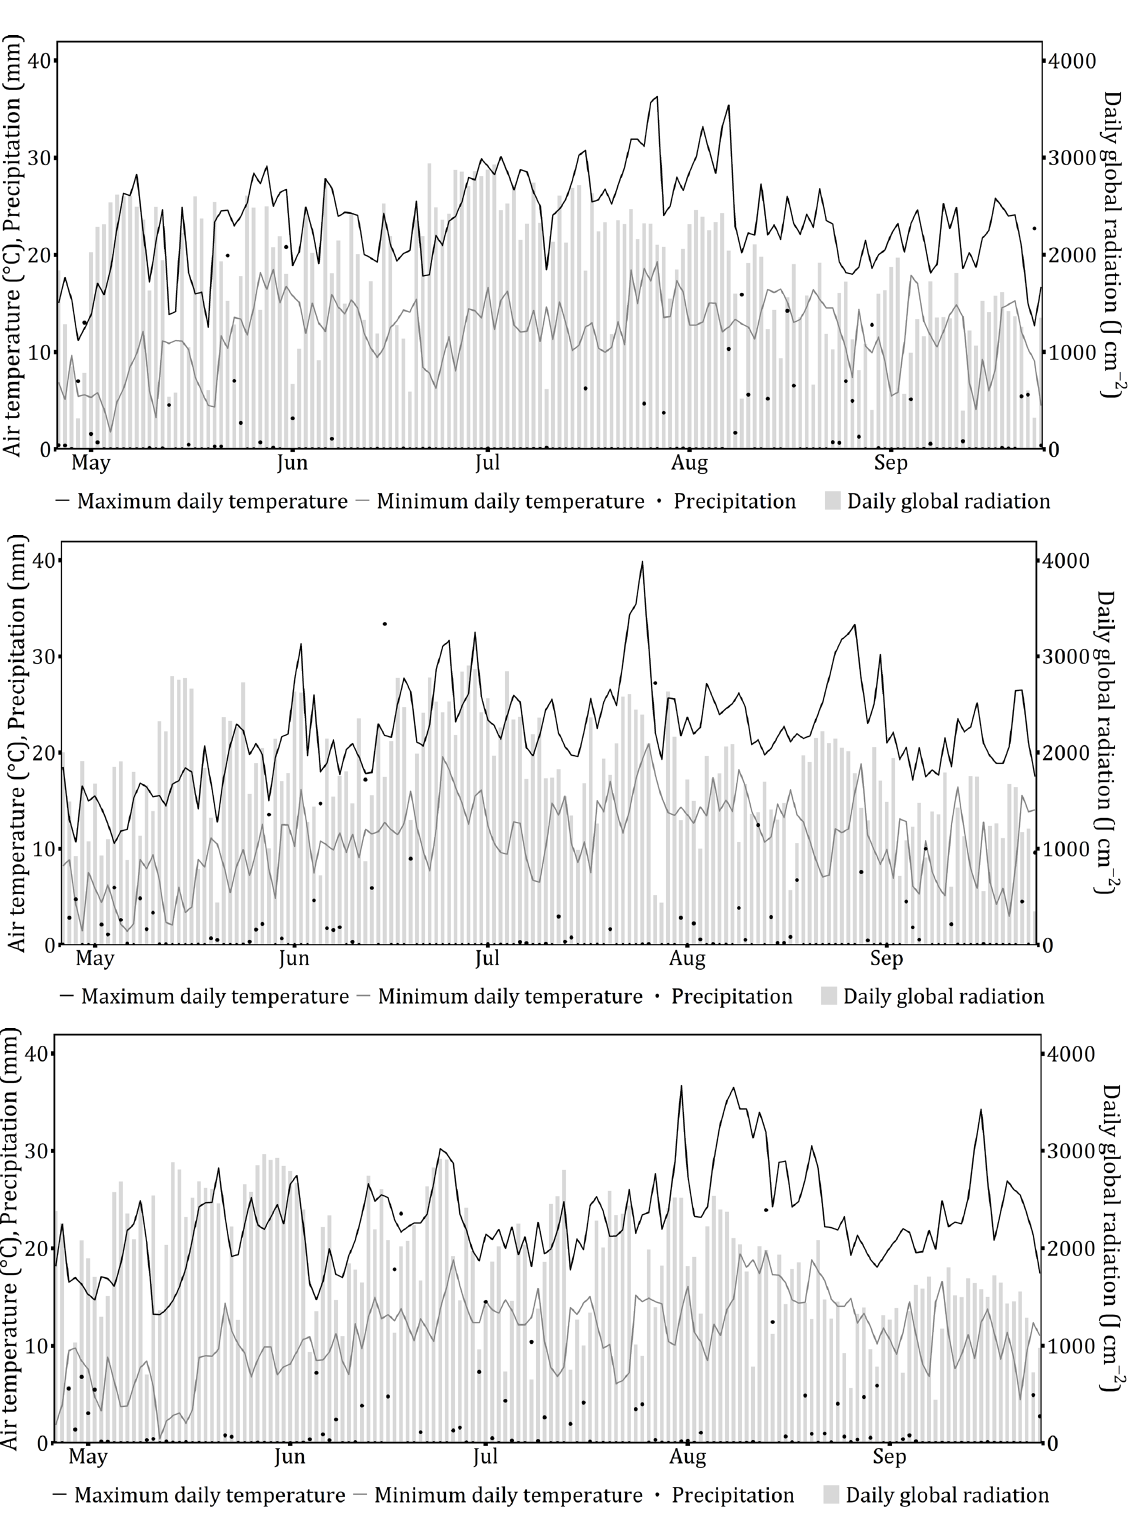
Figure 2. Maximum and minimum daily temperature (°C), precipitation (mm), and daily global radiation (J cm −2 ) during the experimental period of the morphological experiment in 2018 ( top ), 2019 ( middle ), and 2020 ( bottom ).